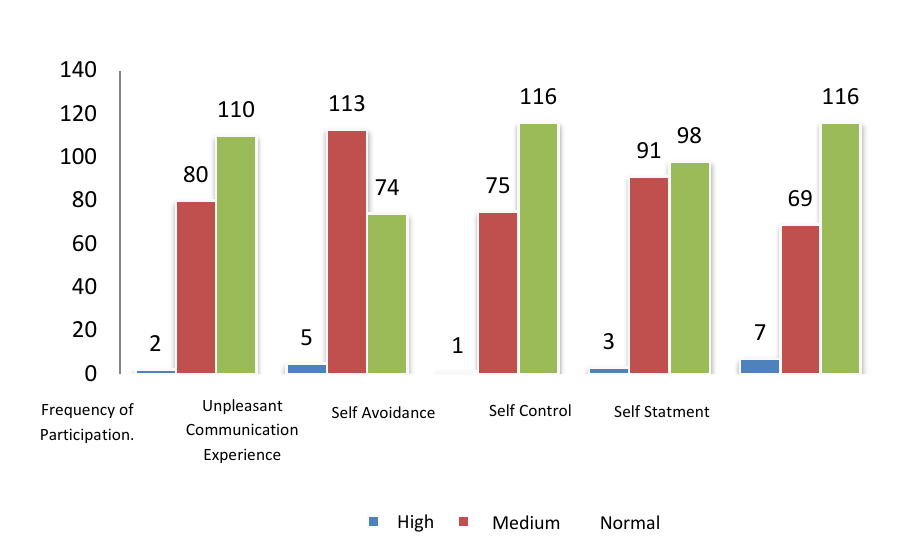
Figure 2: Conditions of student learning anxiety based on anxiety aspects